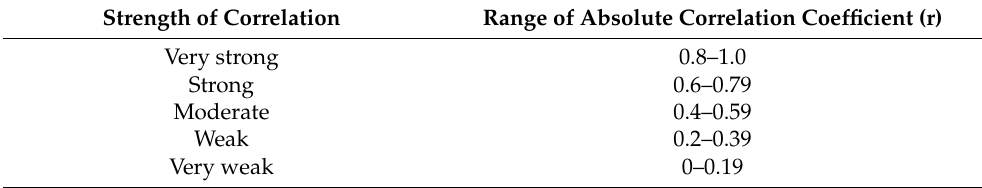
Table 2. Summary of Pearson correlation coefficient (r) strengths